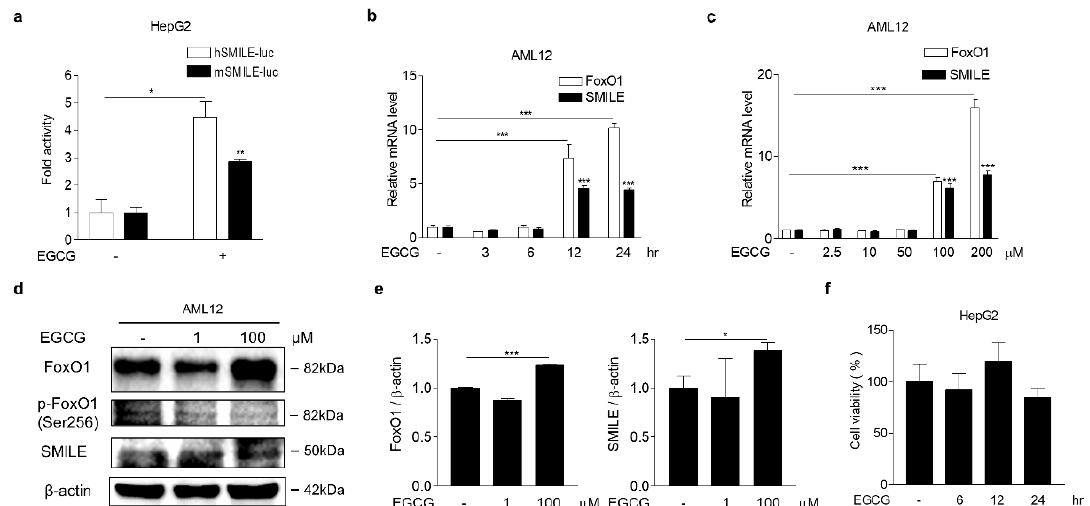
Figure 4. EGCG induces SMILE and FoxO1 expression. ( a ) EGCG effect on human and mouse SMILE promoter activity. HepG2 cells were transfected with vectors encoding human or mouse SMILE-luc (300 ng) and then treated with EGCG (100 µ M) for 12 h. ( b , c ) Time- and dose-dependent mRNA expression of FoxO1 and SMILE by EGCG. AML12 cells were treated with EGCG (100 µ M) for the indicated time ( b ) and dose ( c ) after 2 h of serum starvation. ( d ) Western blot analysis showing FoxO1, p-FoxO1 and SMILE expression in AML12 cells treated with EGCG for 12 h. Gels for western blot analysis were run under the same experimental conditions. ( e ) Graphical representation of FoxO1 (left) and SMILE (right). (f) Cell viability measured using MTT assay. HepG2 cells were treated with EGCG (100 µ M) in a time-dependent manner. The independent experiments were repeated at least twice. The values are presented as means ± SD. * P < 0.05, *** P < 0.001 using two-tailed Student’s t - test.